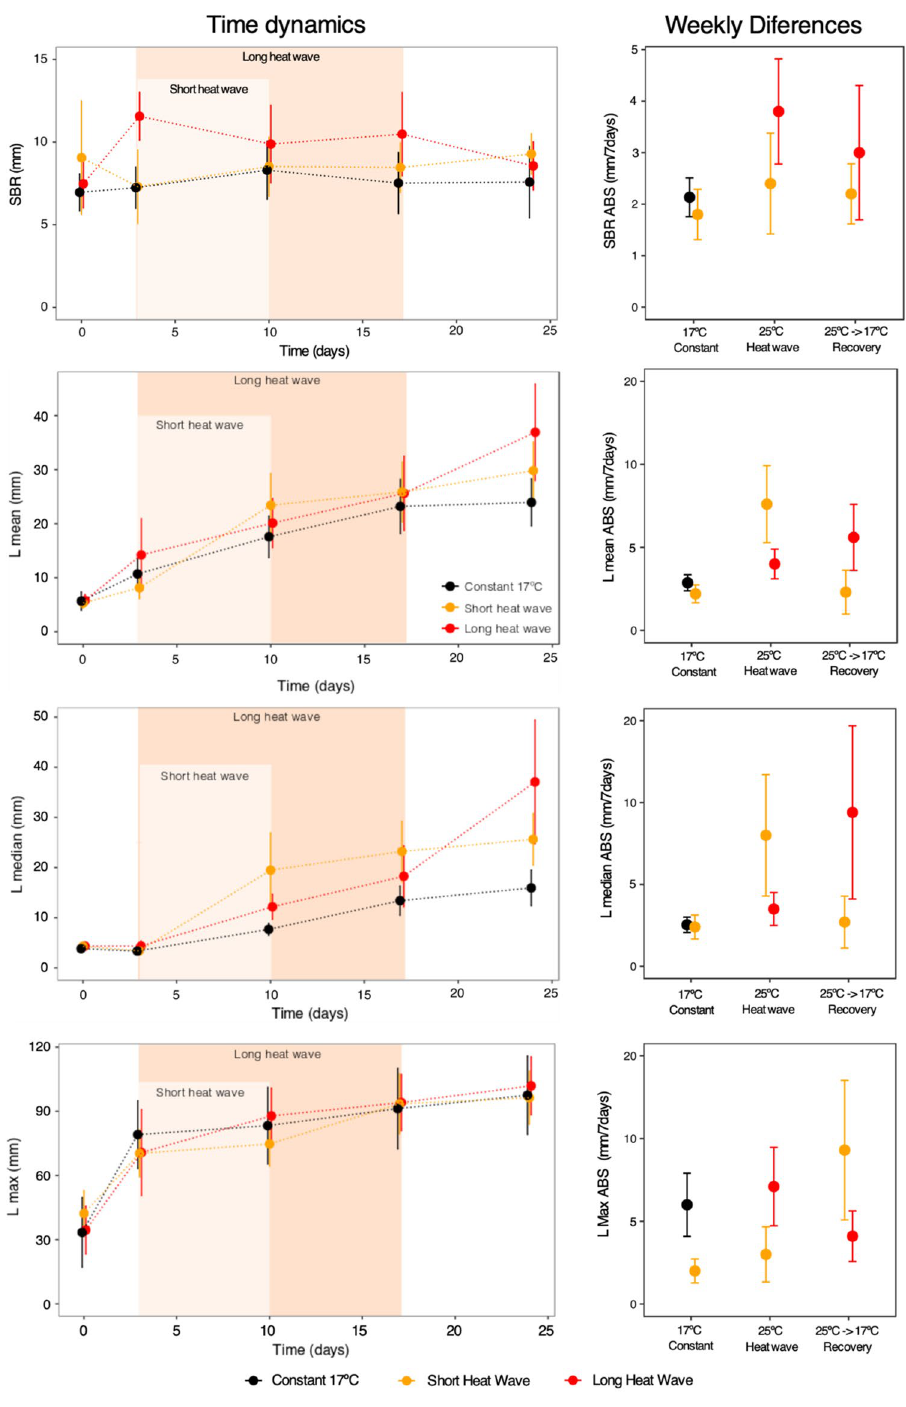
Figure 2. Particles reworking variables’ variation throughout the experimental procedure, considering the three temperature treatments. Left side, temporal dynamics with the indication of the short heatwave and long heatwave periods; right side, the absolute difference for every seven days, considering the constant (17 °C), heatwaves (25 °C) and recovery period, when temperature declined from 25 °C to 17 °C. Graphs done with ggplot2 from R software (https:// ggplo t2. tidyv erse. org) and figure compiled with INKSCAPE (https:// inksc ape.